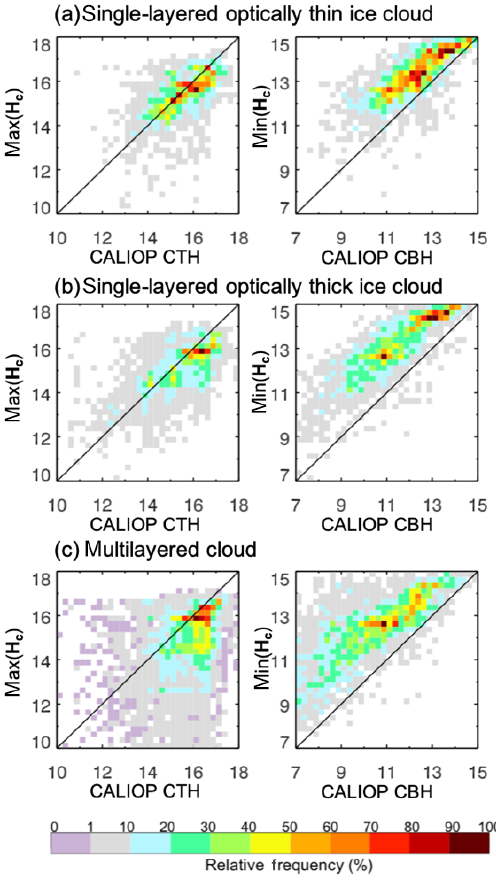
Figure 9. Joint histograms of three cloud categories: (a) single- layered optically thin ice cloud, (b) optically thick ice cloud, and (c) multilayered cloud during August 2015. The first column shows CALIOP CTH (cloud-top height, x axis) versus max( H c ) ( y axis), the second column shows CALIOP CBH (cloud-base height, x axis) versus min( H c ) ( y